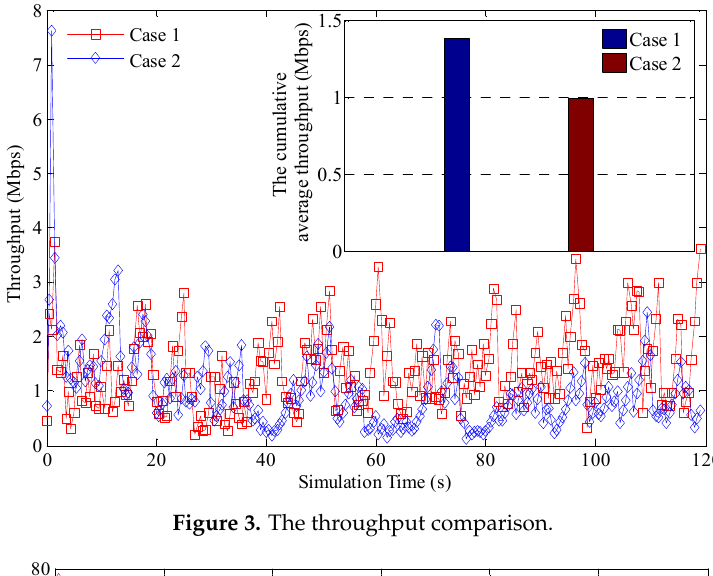
Figure 3. The throughput comparison.